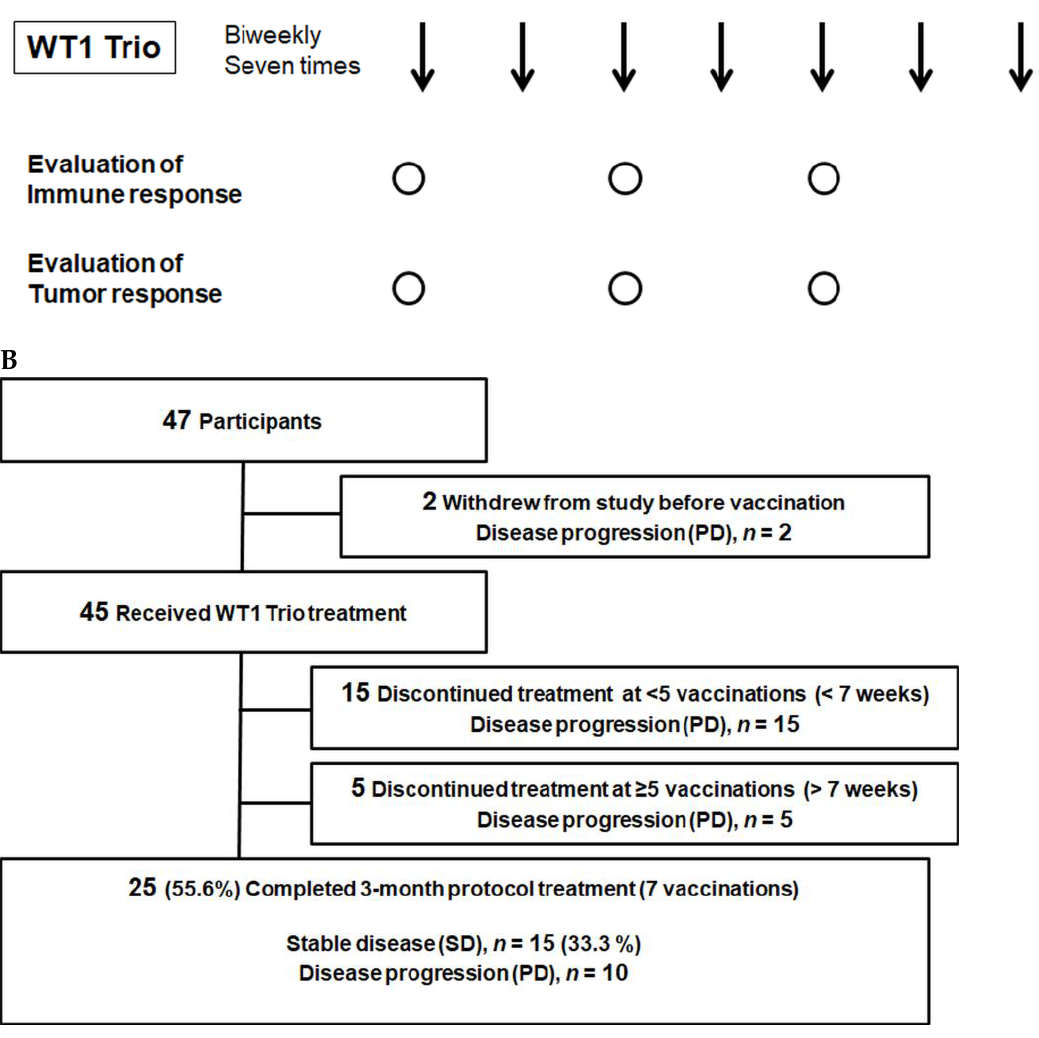
Figure 1. Clinical study design and patient flow chart. ( A ) Clinical trial schema. Arrows, administration of WT1 Trio; circles, Collection of blood samples and image testing. ( B ) Flowchart of the enrolled patients. PD, progressive disease; SD, stable disease.